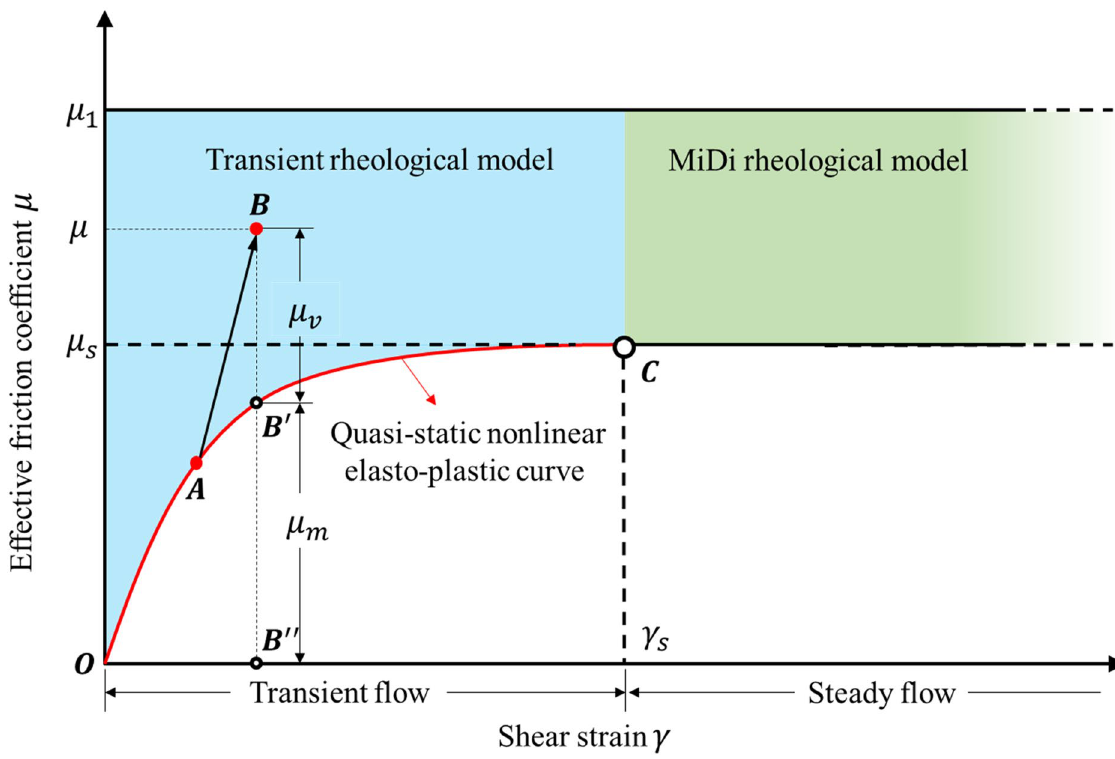
τ/ p ′ in various states of flow of granular Figure 1. Components of the effective friction coefficient µ = OC is the quasi-static stress–strain relation described by soil mechanics in the solid-like materials. The red line quasi-static domain. The green area is the domain of steady state flow described by the MiDi rheological model. (cid:31) The blue area is the domain of transient flow described by the transient rheological